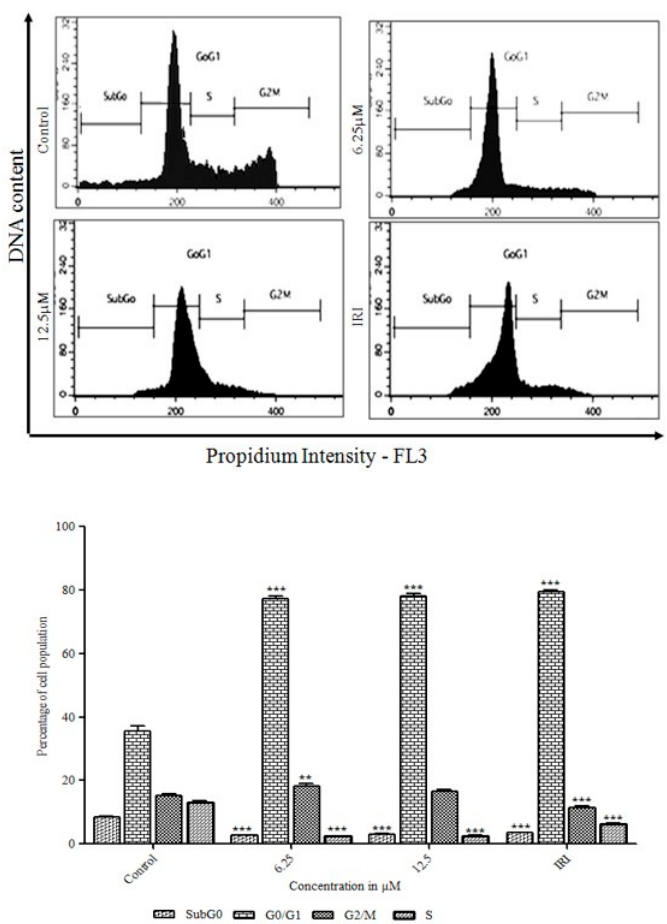
Figure 4. Effect of orientin on cell cycle phase distribution in HT29 cells. HT-29 cells were treated with different concentrations of orientin and analyzed after 24 h for DNA content by flow cytometry. Histogram representing the PI (propidium iodide) staining (FL2-A) of orientin treated cells. The data shown are representative of three independent experiments with similar findings. The significant differences from control were indicated by * p < 0.05, ** p < 0.01 and *** p < 0.0001 (considered as statistically significant).